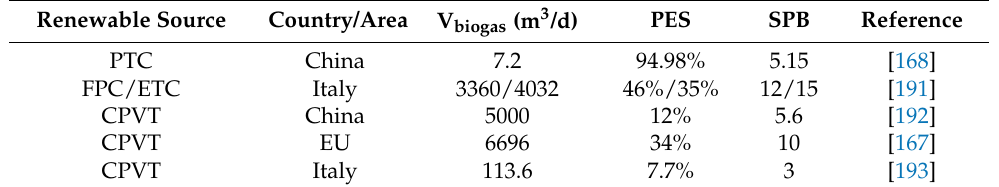
Table 7. Literature works on biomethane plants, including the integration with solar energy systems. Renewable Source Country/Area V biogas (m 3